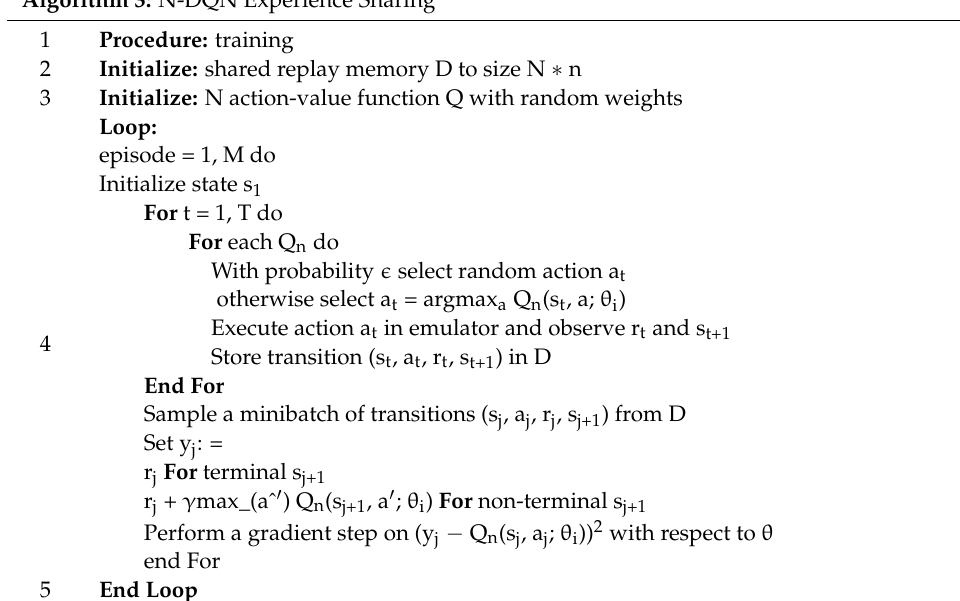
Algorithm 3: N-DQN Experience